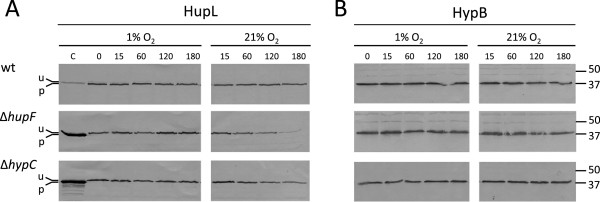
Effect of HupF on HupL stability under high oxygen tensions. Time course of immunodetection of HupL (panel A) and HypB (panel B) proteins in cell crude extracts from cultures previously induced for hydrogenase activity and then bubbled with 1% O2 or air (21% O2) for the indicated periods of time (min). Top, medium, and bottom panels correspond to cell extracts from R. leguminosarum UPM1155 derivative strains harboring plasmids pALPF1 (wt), pALPF5 (ΔhupF), and pALPF14 (ΔhypC), respectively. Conditions of SDS-PAGE and loading are as in Figure 
2. Lanes labelled as 0 contain control crude extracts harboring either unprocessed HupL from UPM1155(pALPF14) (ΔhypC), in top panel, or processed HupL from UPM1155(pALPF14) (wt), in medium and bottom panels as controls. Marks on the left margins indicate the position of the unprocessed (u, 66 kDa) and processed (p, 65 kDa) forms of HupL in panel A, and marks on the right margins indicate the position of molecular weight markers.